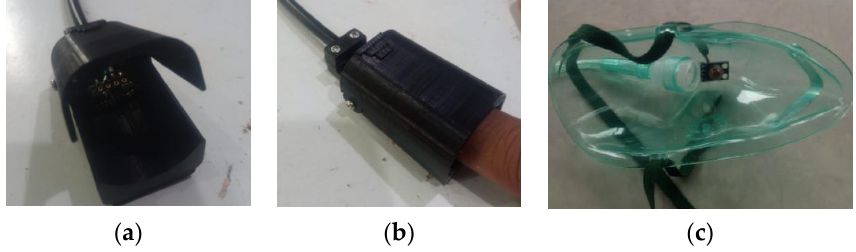
Figure 12. Sensor placement ( a ) in finger clip; ( b ) finger placement in clip; ( c ) respiration sensor.